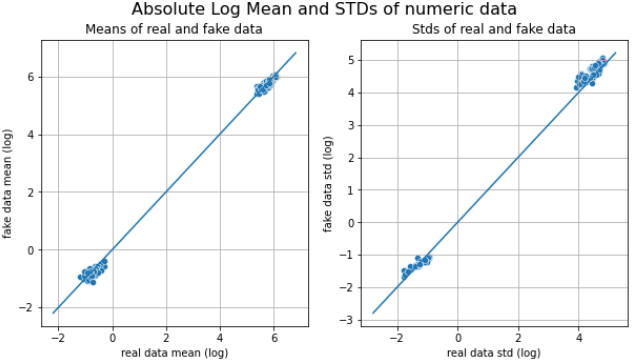
Figure 3. Relationship between the distribution of real data and generated synthetic data: Mean ( left ) and standard deviation ( right